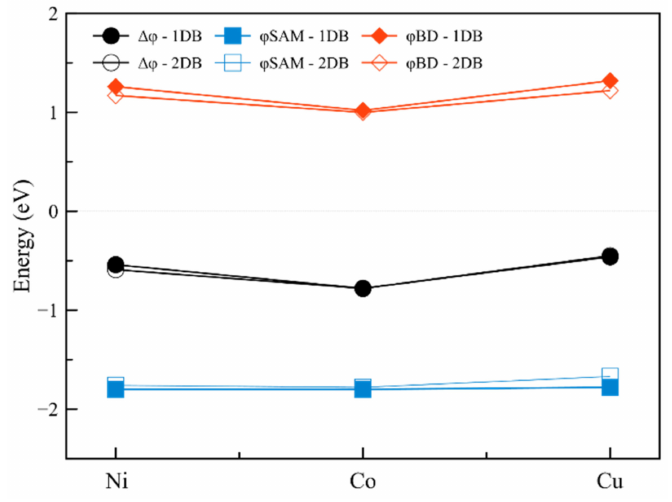
Figure 4. Total work function shift (black) and its two components: contribution of dipole moment of the molecule (blue) and contribution of bond dipole (red) for interfaces when two SAM-molecules are introduced to the graphene